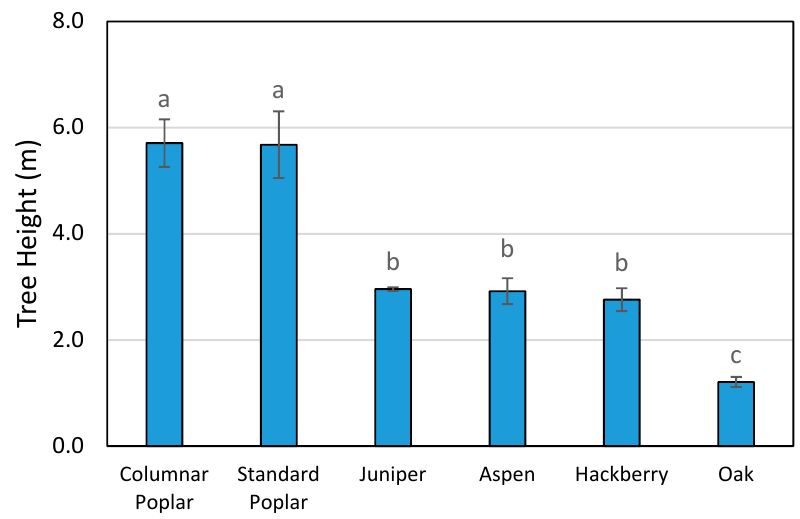
Figure 1. Average height of species compared for windbreaks. Vertical bars indicate standard error, and letters indicate difference at p < 0.05. Columnar poplar and standard poplar showed the greatest height gain from 2014 to 2018, with average heights of 5.71 and 5.68 m, respectively. Oak had the least height gain, with an average height of 1.21 m.